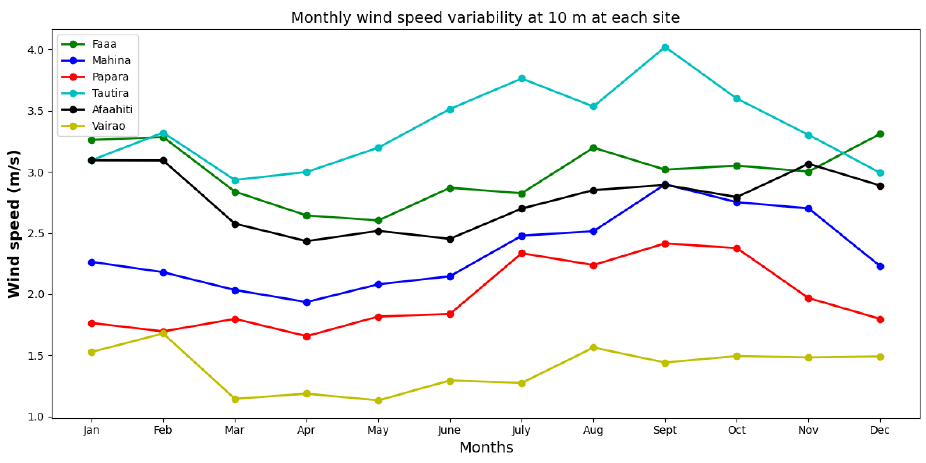
Figure 3. Monthly wind speed at 10